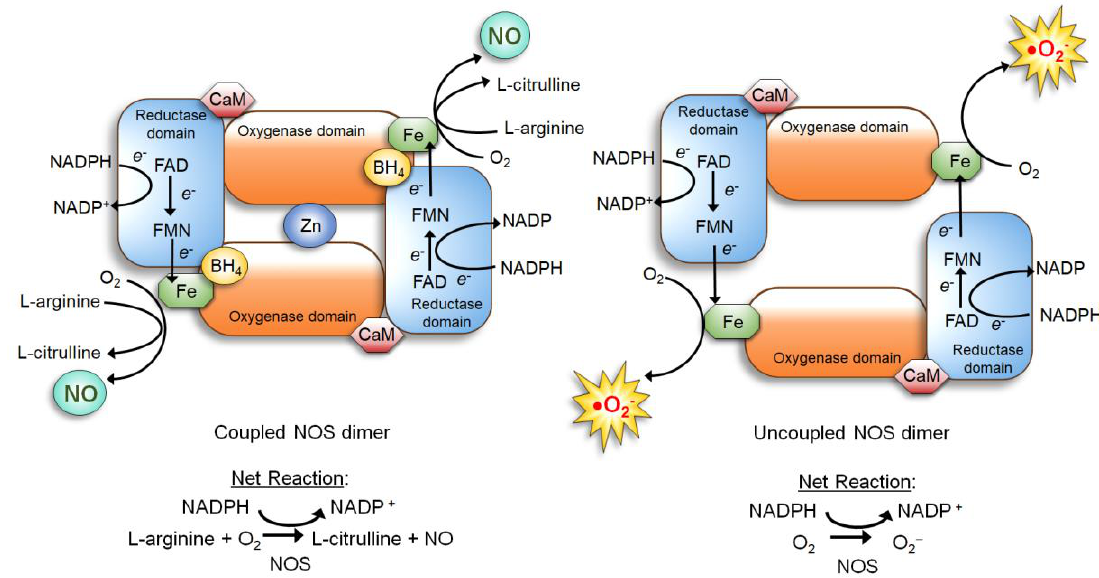
Figure 1. Nitric Oxide Synthase (NOS) dimer in the coupled (normal) vs. uncoupled states [40]. ( Left ) In the normal coupled state, two NOS monomers are tethered by BH 4 , which also increases the binding affinity of the substrate L-arginine. Furthermore, the NOS dimer is stabilized by a zinc ion coordinated in the oxygenase domains of two monomers. Dimerization allows the coupling of two reactions: 1) electron flow: nicotinamide adenine dinucleotide phosphate (NADPH) → flavin adenine dinucleotide (FAD) → flavin mononucleotide (FMN) → Fe of the heme → molecular oxygen; and 2) oxidation of L-arginine. This coupling yields NO and L-citrulline. ( Right ) When the BH 4 level is scarce, NOS remains as a monomer and fails to bind L-arginine. The electron flow to molecular oxygen (Reaction 1) is uncoupled to L-arginine oxidation (Reaction 2), yielding superoxide (O 2 • − ).